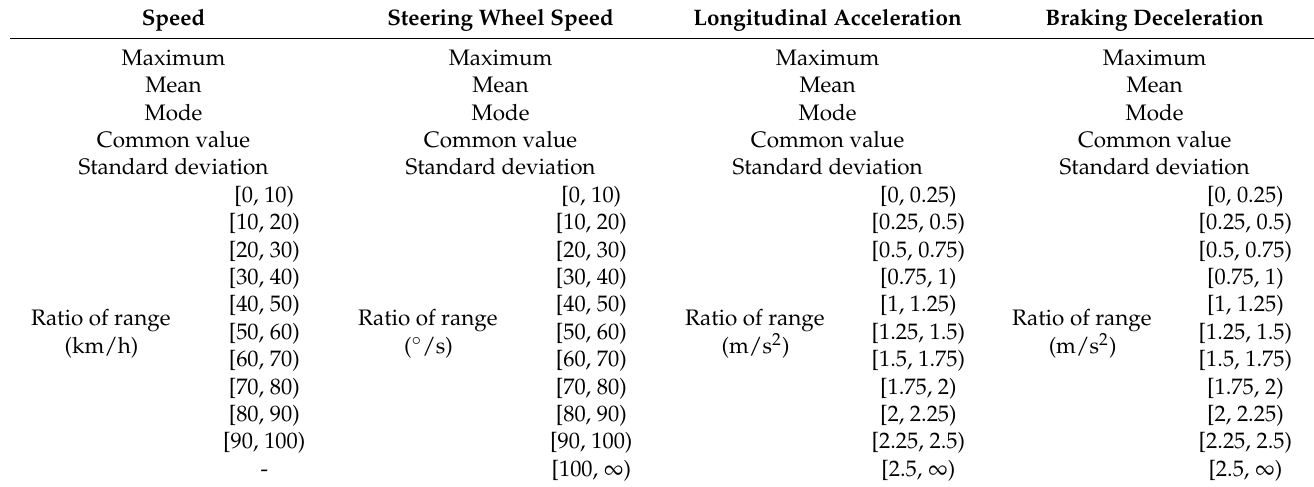
Table 2. The 63-dimension statistical characteristic parameters.